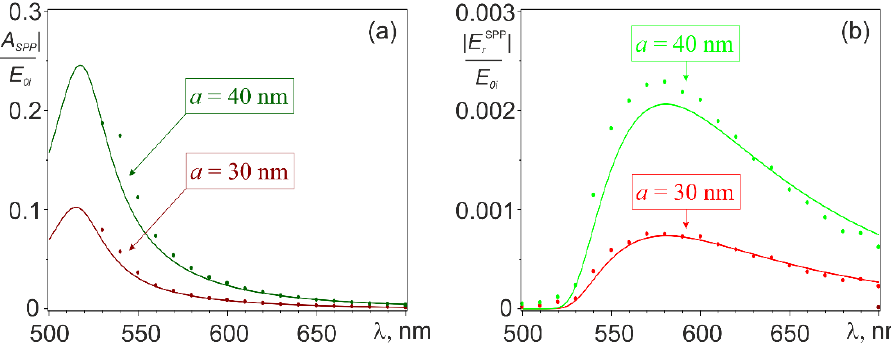
Figure 2. The efficiency ( a ) and amplitude at a distance of 8 μm from the excitation center ( b ) of the SPP wave vs. the incident wavelength, at d = 10 nm. Solid curves and dots are the results of the analytical and numerical calculations, respectively.